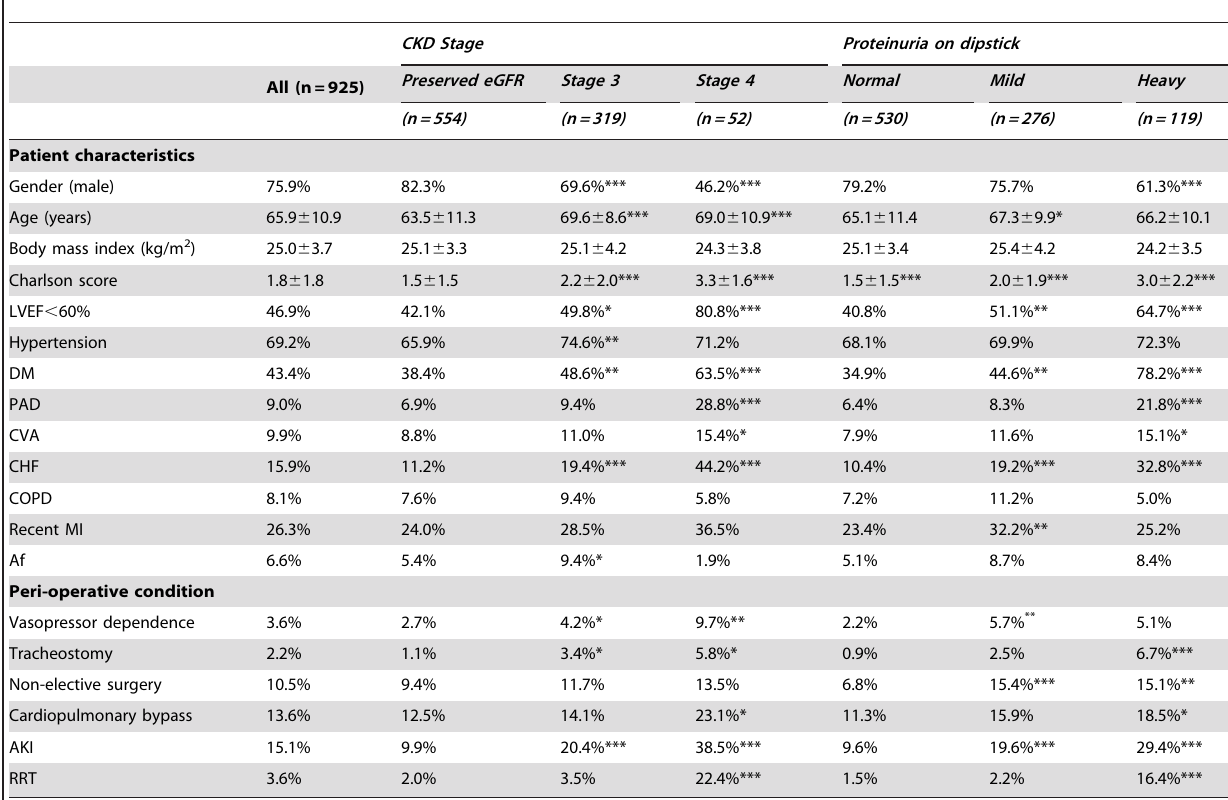
Table 1. Patients’ demographics, classified by CKD stages or